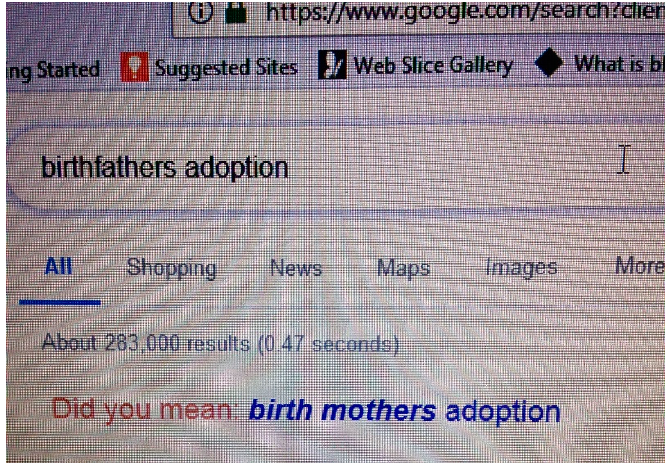
Figure 1. Google and birthfathers.